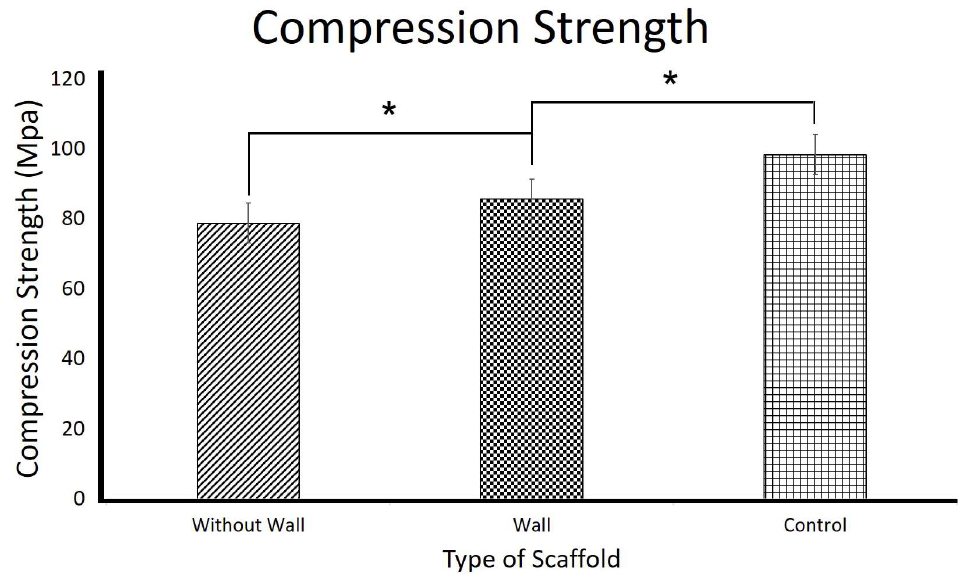
Figure 7. Compressive strength of the 3D scaffolds. (* p < 0.05).